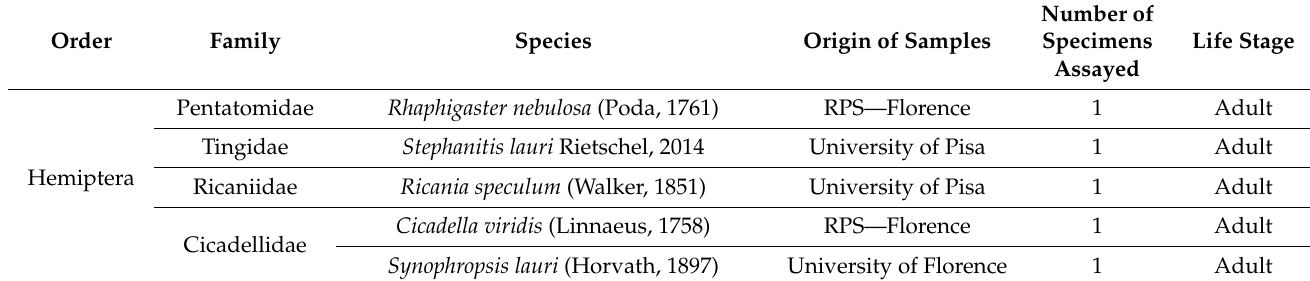
Table 5. List of samples (target specimens from the Maremma Regional Park and non-target specimens from other Tuscan sites) used to set up the molecular diagnostic assay. RPS: Regional Phytopathologi- cal